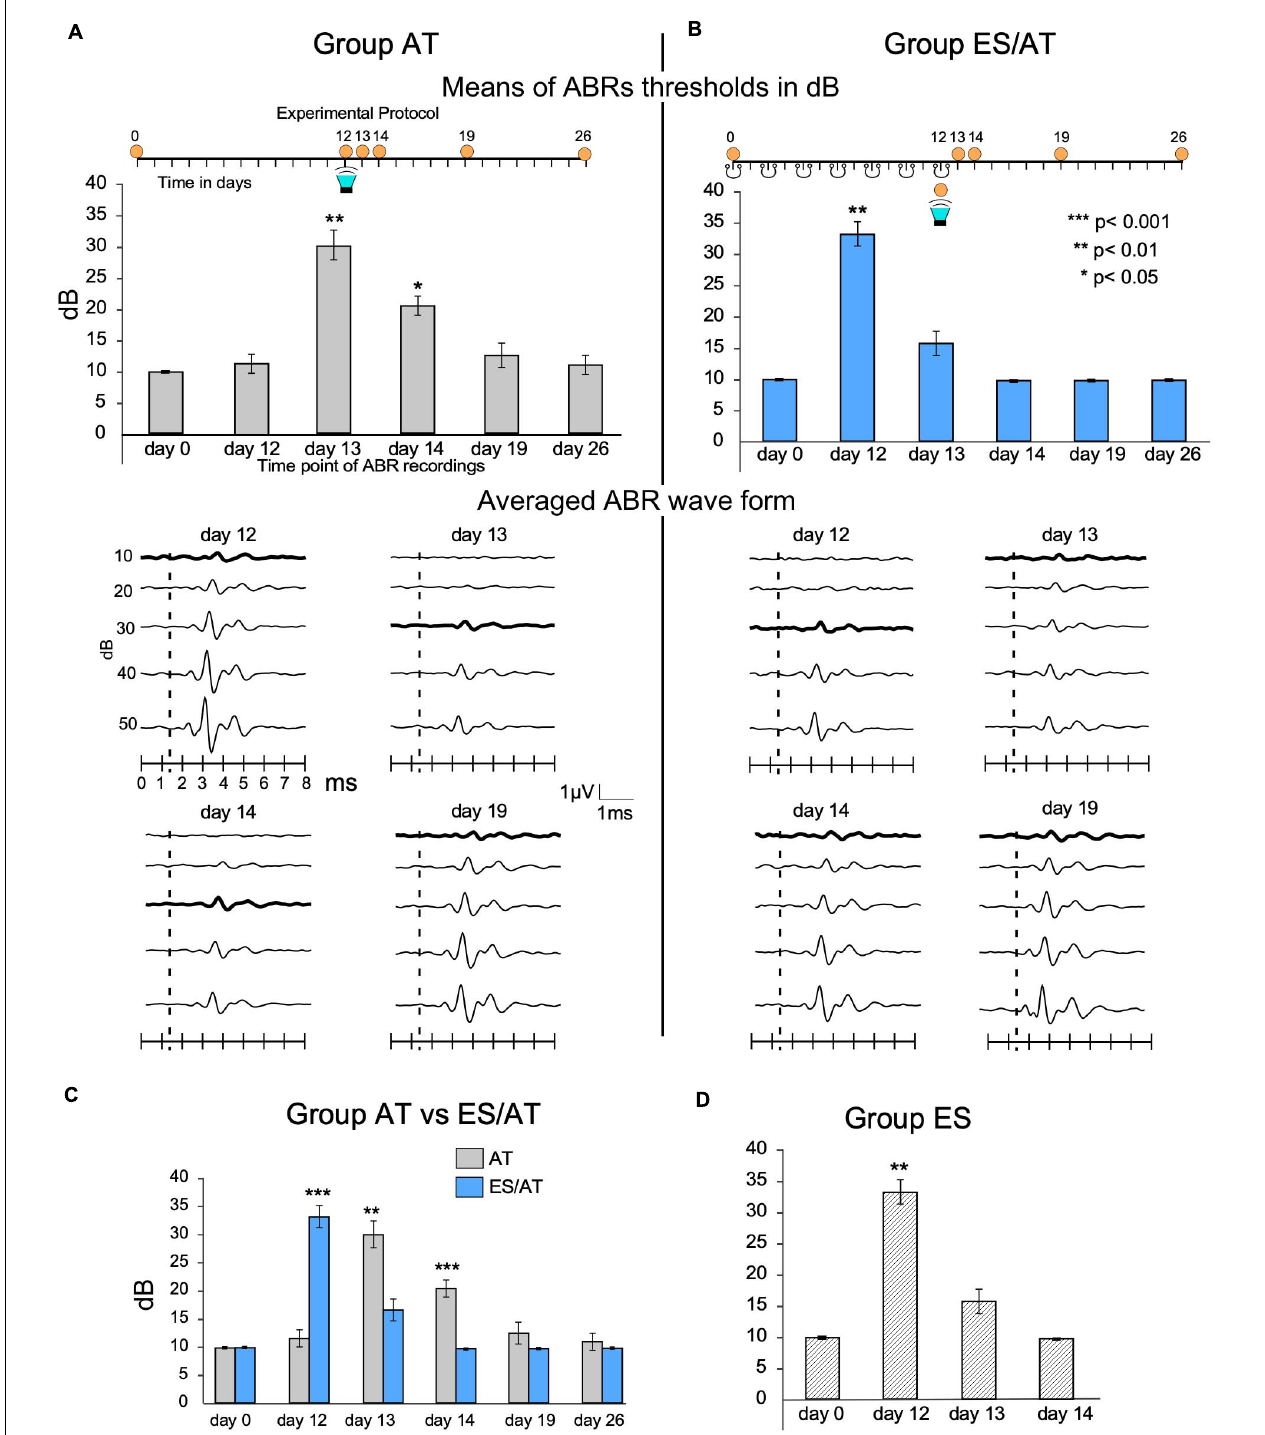
FIGURE 4 | Thresholds and waveform analysis of ABRs. (A) The AT group shows a significant threshold shift at AT + 1 day (day 13) and AT + 2 days (day 14). (B) The ES/AT group shows a significant threshold shift before, but not after, overstimulation (the green loudspeaker labels acoustic stimulation). Waveform analysis is shown in the middle of the panel. Lines represent averaged waves from all animals of each group. The thickest lines label averaged thresholds. (C) Statistical comparison of the mean thresholds of groups AT vs. ES/AT. Note significant differences in threshold shifts after AT at day 13, the day after acoustic stimulation. Please also note that, in the days after the recordings, the thresholds recover later in the AT group than in the ES/AT group. (D) ES group. Multisession epidural stimulation induces threshold shifts immediately after the last stimulation on day 12, which recovers 1 day later (day 13).